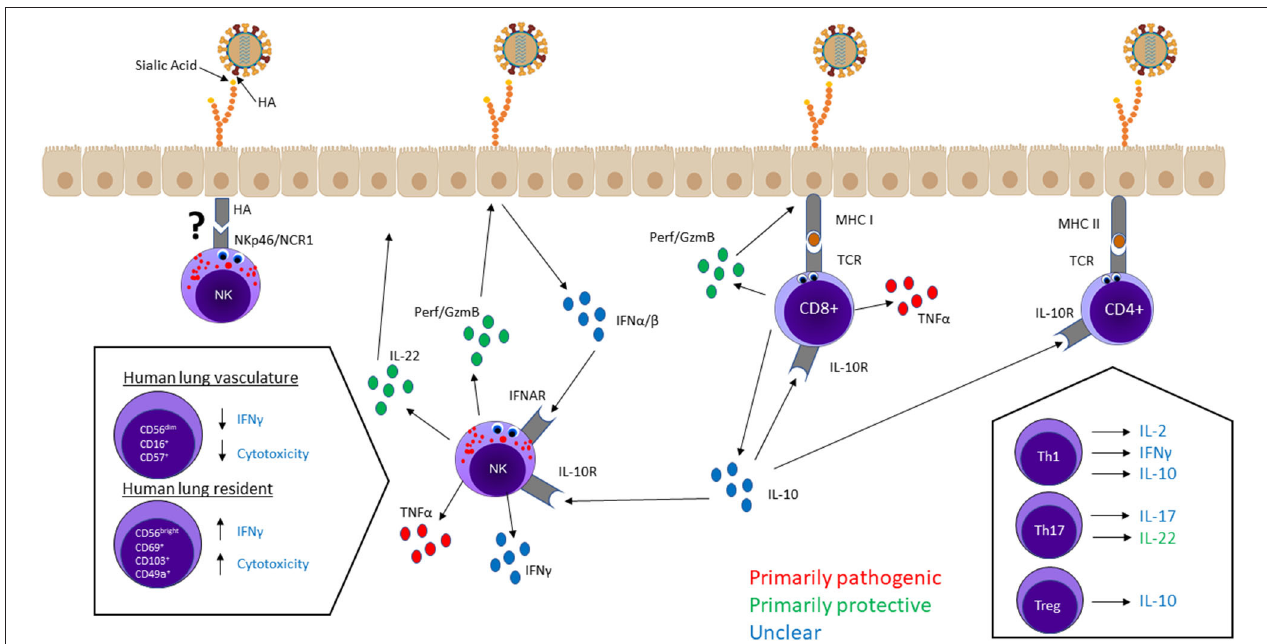
FIGURE 1 | NK cell and T cell effector functions in the lung—cytokine secretion and cytotoxicity—mediate viral clearance and lung immunopathology. Most lung NK cells are terminally differentiated hypofunctional cells circulating in the lung vasculature, whereas a small population of immature lung-resident cells are capable of higher cytotoxicity and cytokine production. CD8 + T cells and NK cells mainly kill infected cells through cytotoxic granules containing perforin and granzymes. Cytotoxicity is not believed to have serious pathological consequences. T cells and NK cells produce a variety of cytokines, some of which—IFN- γ , IL-2, IL-10, IL-17—have unclear effects on host outcome. TNF- α seems to be a significant contributor to lung damage but not required for protection. Alternatively, tissue-regenerative cytokine IL-22 is considered an important protective factor. IL-10 regulates NK cell and T cell responses, but it is unclear whether higher levels of IL-10 improve or worsen host